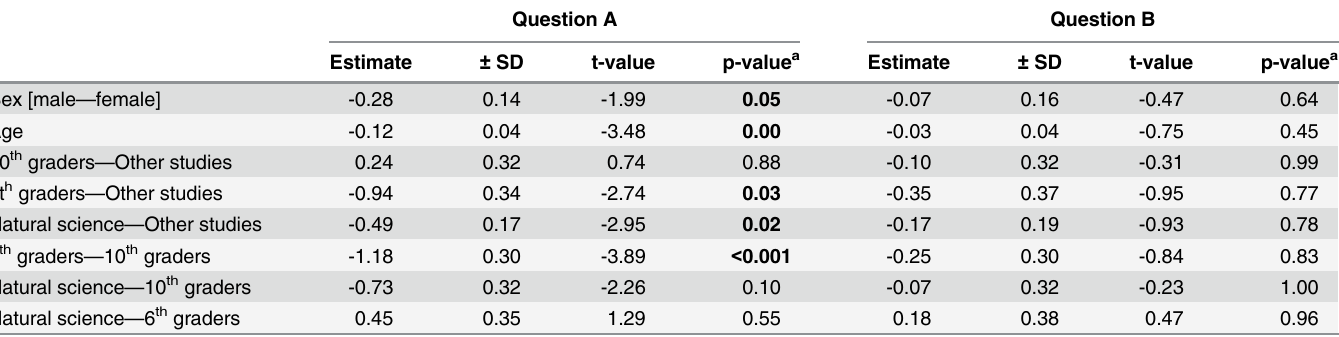
Table 2. Co-existence of scientific and alternative conceptions in dependence of educational background (6 th graders, 10 th graders, natural sci- ence freshmen, and other academia studies freshmen), sex and age; based on binomial-linear models and pre-defined model contrast for multiple comparisons among educational backgrounds (n = 885).